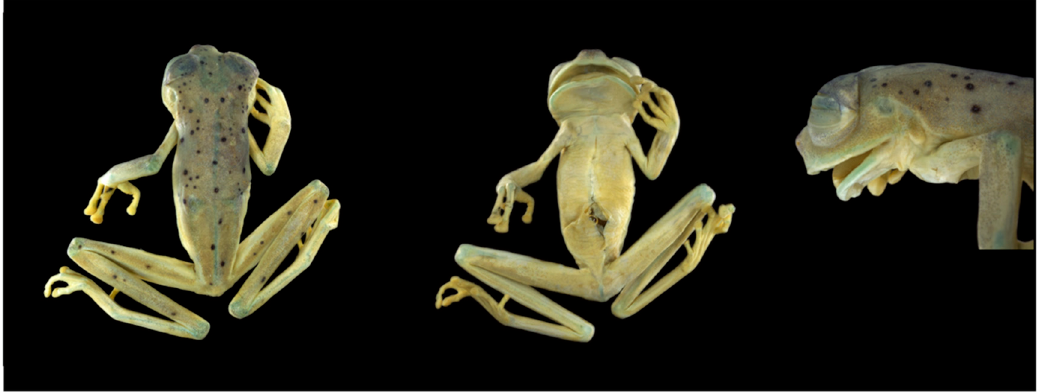
Figure 143. Nymphargus cochranae , holotype in preservative, BMNH 1912.11.1.68. Ecuador, El Topo, Río Pastaza. Photos by Martín Bustamante.